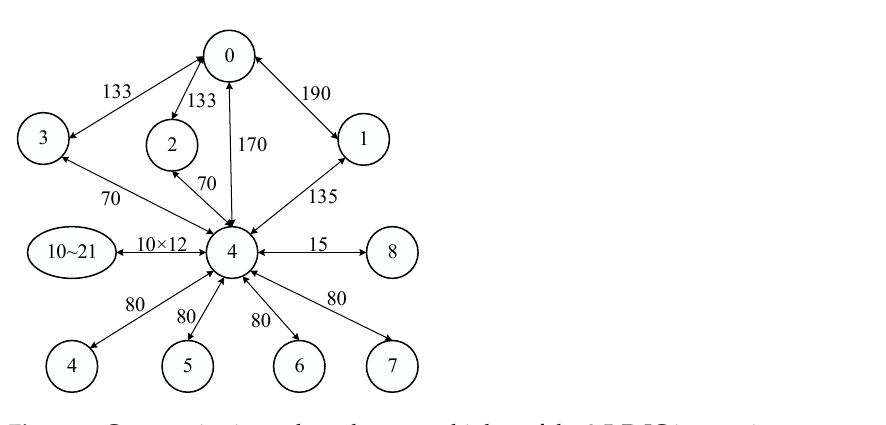
Figure 2. Communication volume between chiplets of the 2.5-D IC integration.